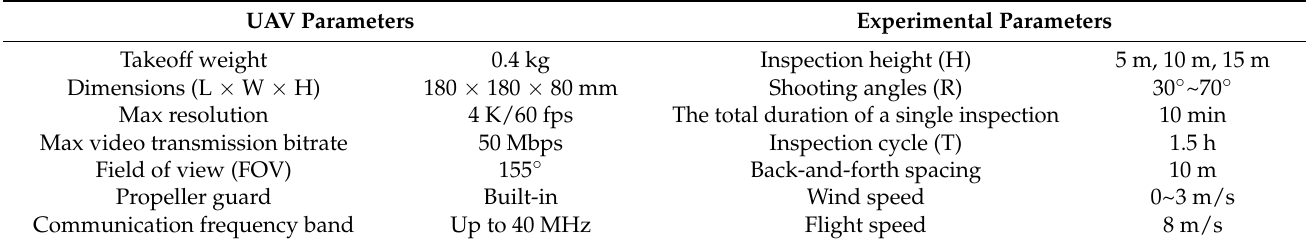
Figure 3. UAV body attitude during the inspection. Table 1. DJI Avata UAV camera and aerial